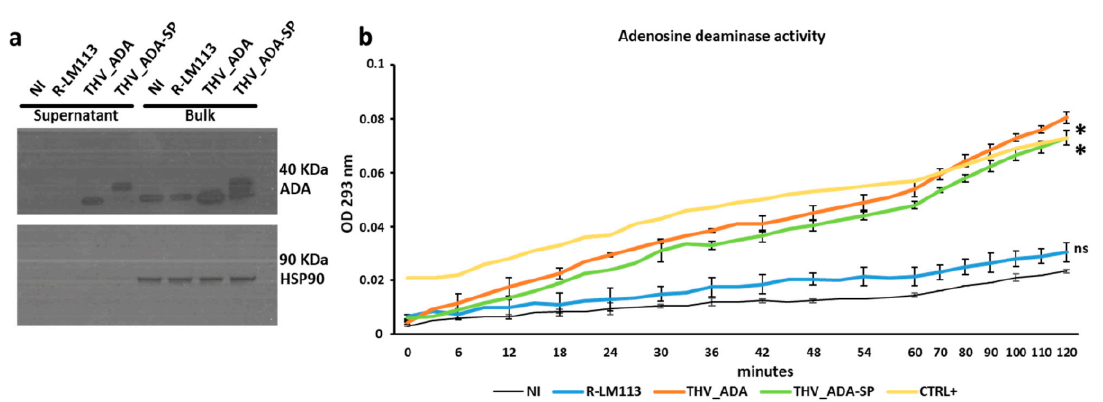
Figure 4. Biochemical characterization of ADA payload. ( a ) Expression of mADA was evaluated by western blot analysis in supernatants and bulk (whole cell lysate) of non-infected (NI), R-LM113, THV_ADA, THV_ADA-SP, and infected SKOV3 cells three days after infection at MOI of 0.1 pfu/cell. ( b ) Adenosine deaminase activity was measured in the supernatants described in the panel ( a ). Statistical significance was calculated between non-infected cells (NI, black line) and all the samples (R-LM113, blue line; THV_ADA, orange line; THV_ADA-SP, green line) and is reported as * for p -value < 0.05 and ns for not statistically